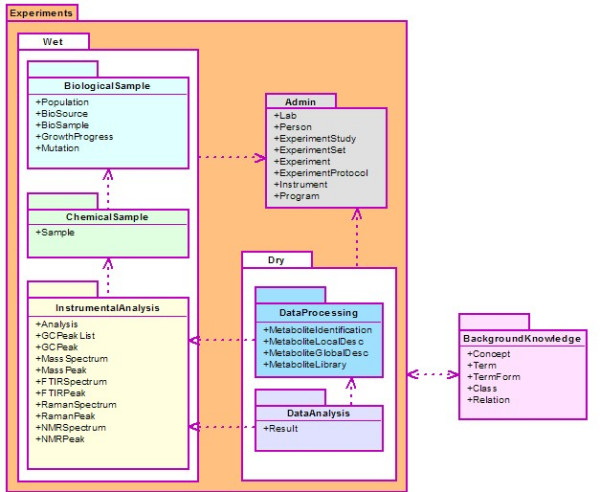


Global overview of MeMo. The global components of MeMo represented by UML packages.